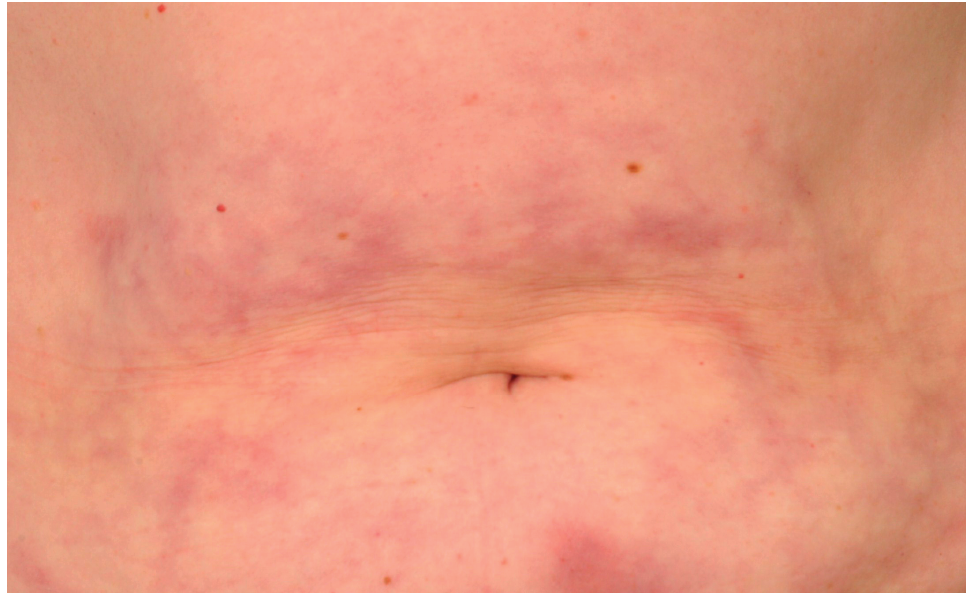
Figure 1. Characteristic injection site reactions in a patient injecting IFN- β